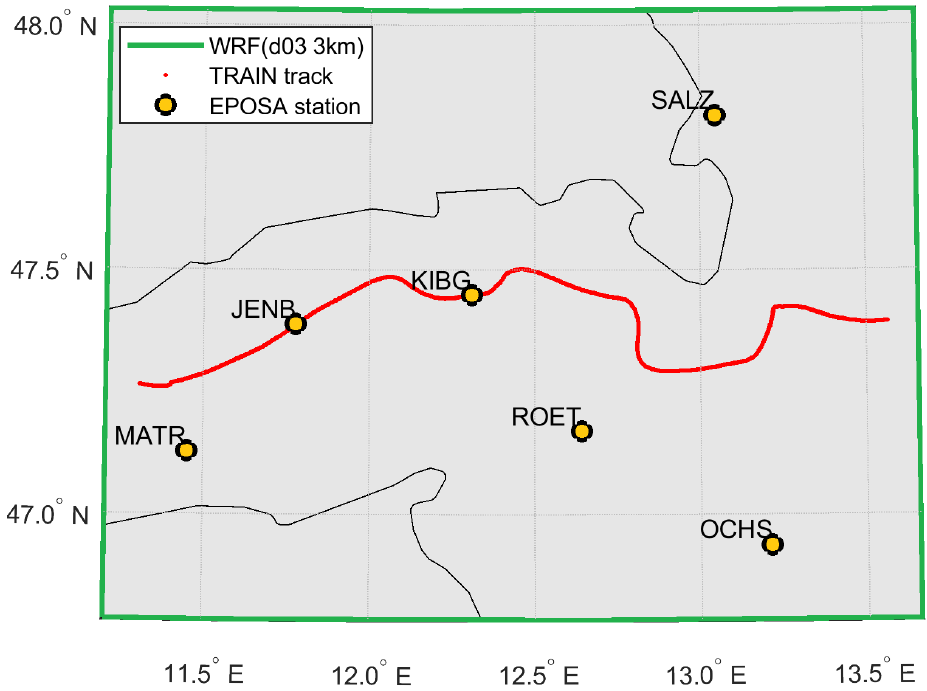
Figure 12. The WRF model domain (green) with covered train track (red) and nearby EPOSA stations utilized for comparison (orange dots).